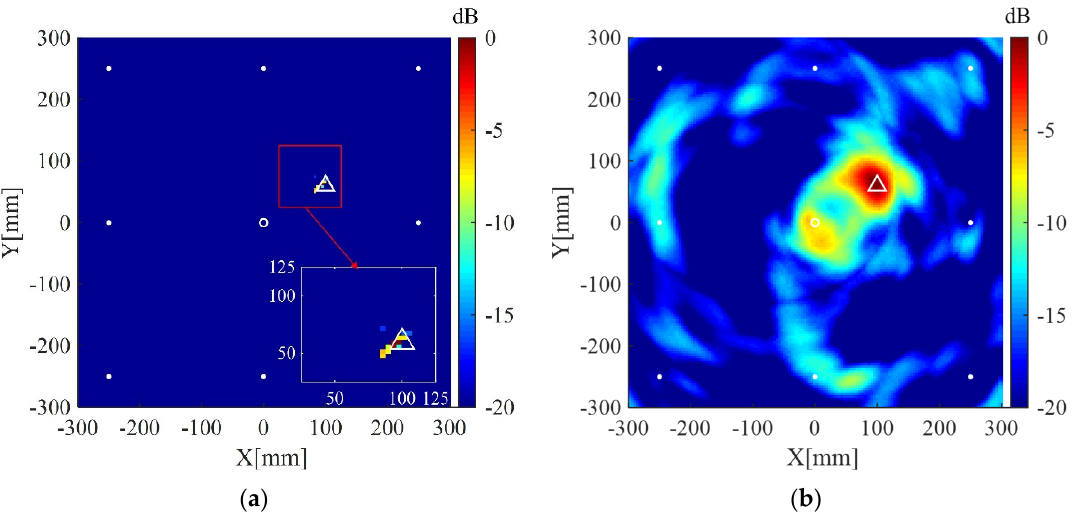
Figure 8. ( a ) Imaging result of the weighted structured sparse reconstruction ‐ based Lamb wave imaging method using data from eight receivers (the location error is 3 mm); ( b ) Imaging result of the delay ‐ and ‐ sum imaging method using data from eight receivers (the location error is 3 mm). White dots denote locations of PZT receivers, the white circle denotes the location of excitation source, and the white triangle denotes the location of the scatterer.